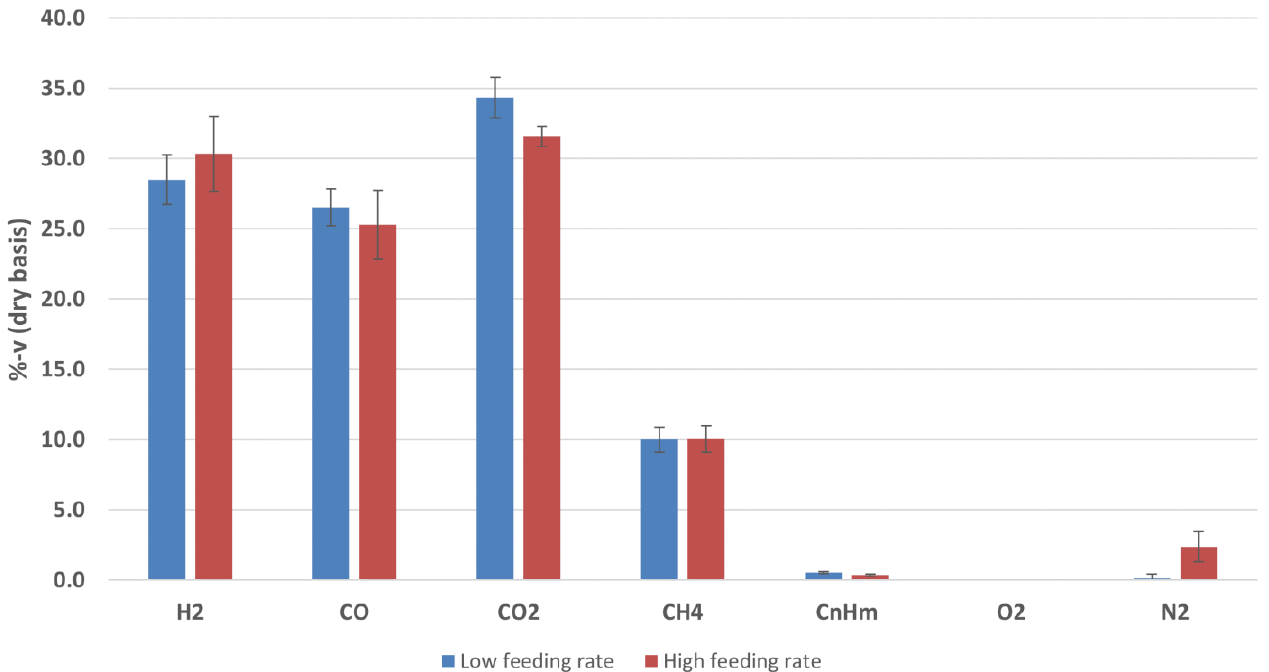
Figure 5. Average compositions of the producer gas obtained in the gasification tests at low and high biomass feeding rates. Percentages by volume, referred to dry gas.